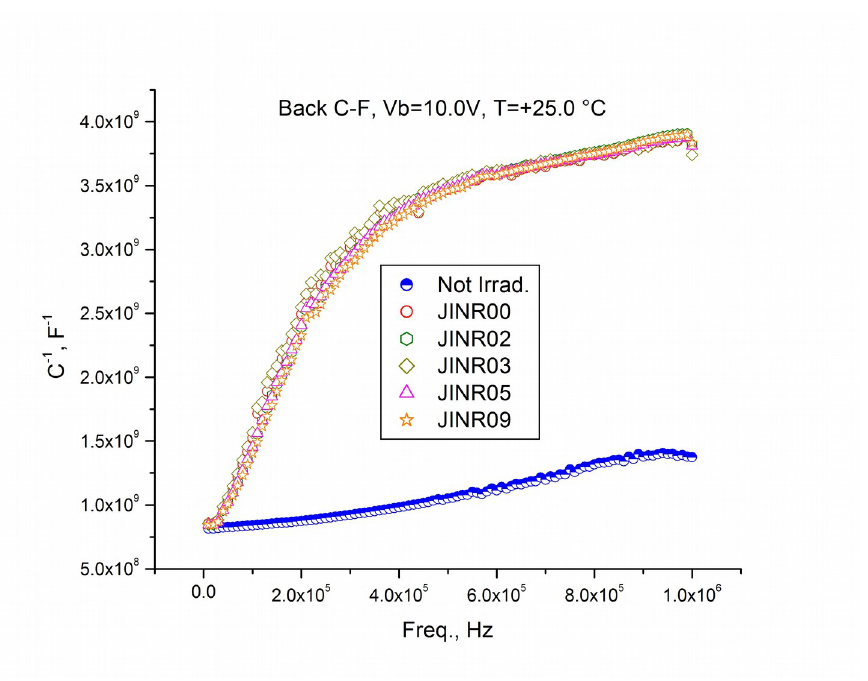
Figure 3. Change of the ratio <T>/<N> for irradiated and not irradiated SiPM obtained from the analysis C-F characteristics (T=25 ° C,